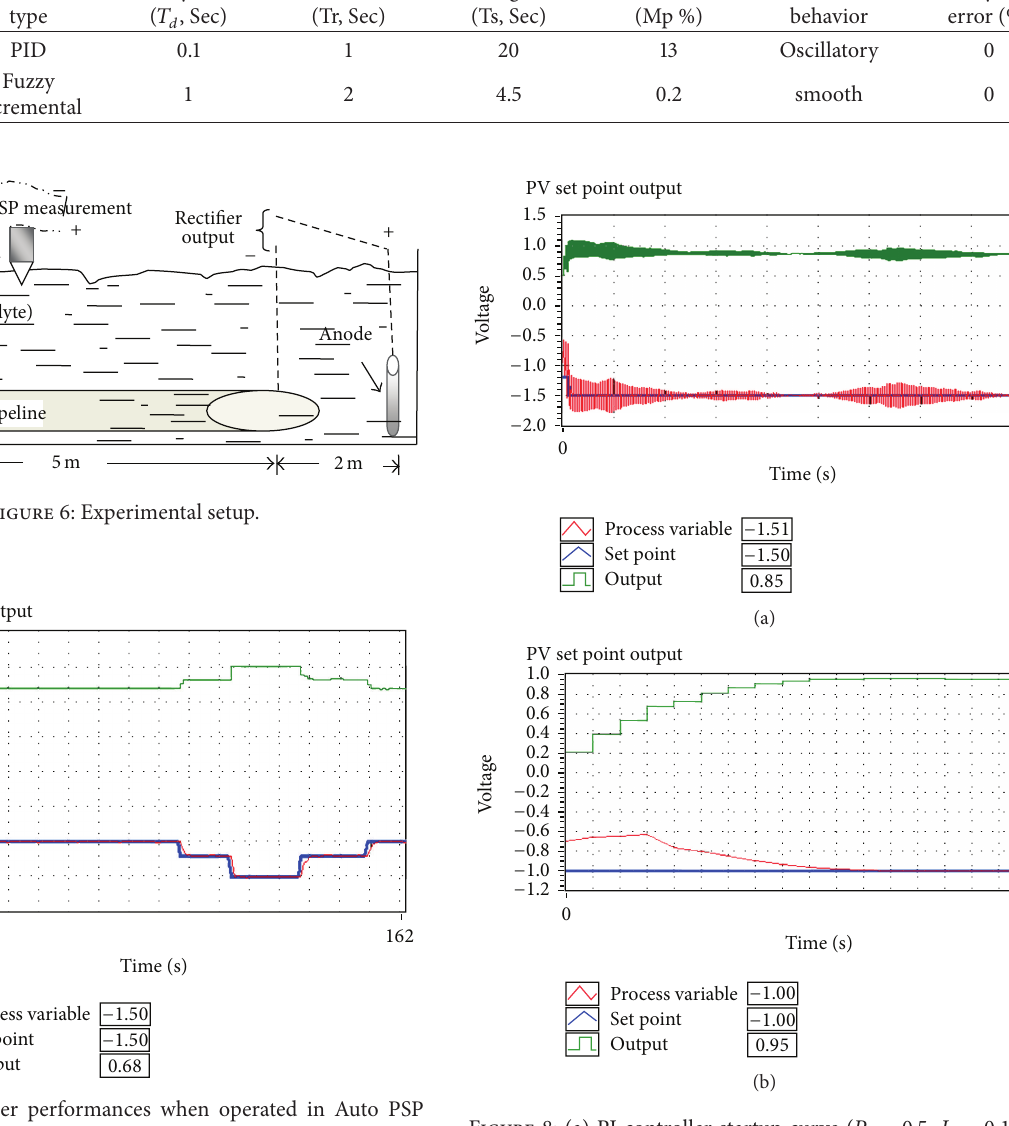
𝑃 = 0.5 , 𝐼 = 0.18 ). (b) Startup curve with fuzzy